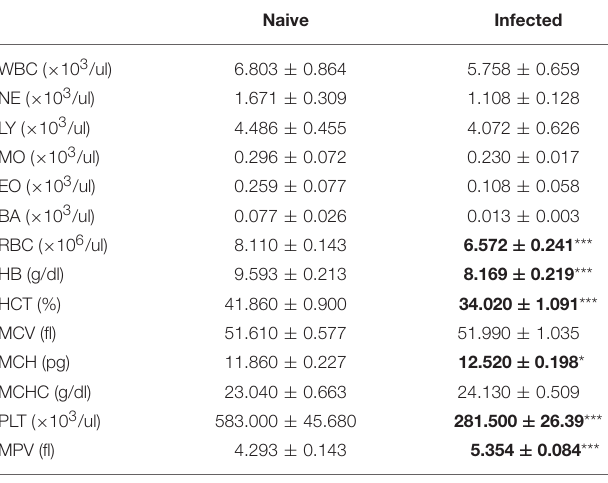
TABLE 1 | Hematological characteristics of C57BL/6 mice infected for 28 days with L. donovani . Naive